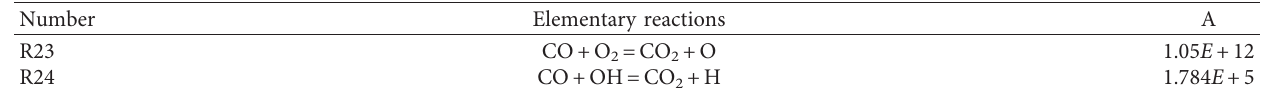
Figure 15: Ratio of the second-stage ignition delay time of different initial temperatures for methane/syngas/n-heptane mixtures at β � 2.112 × 10 − 2 , p � 40 bar, and ϕ � 1. Table 2: Important reactions for the ignition processes of